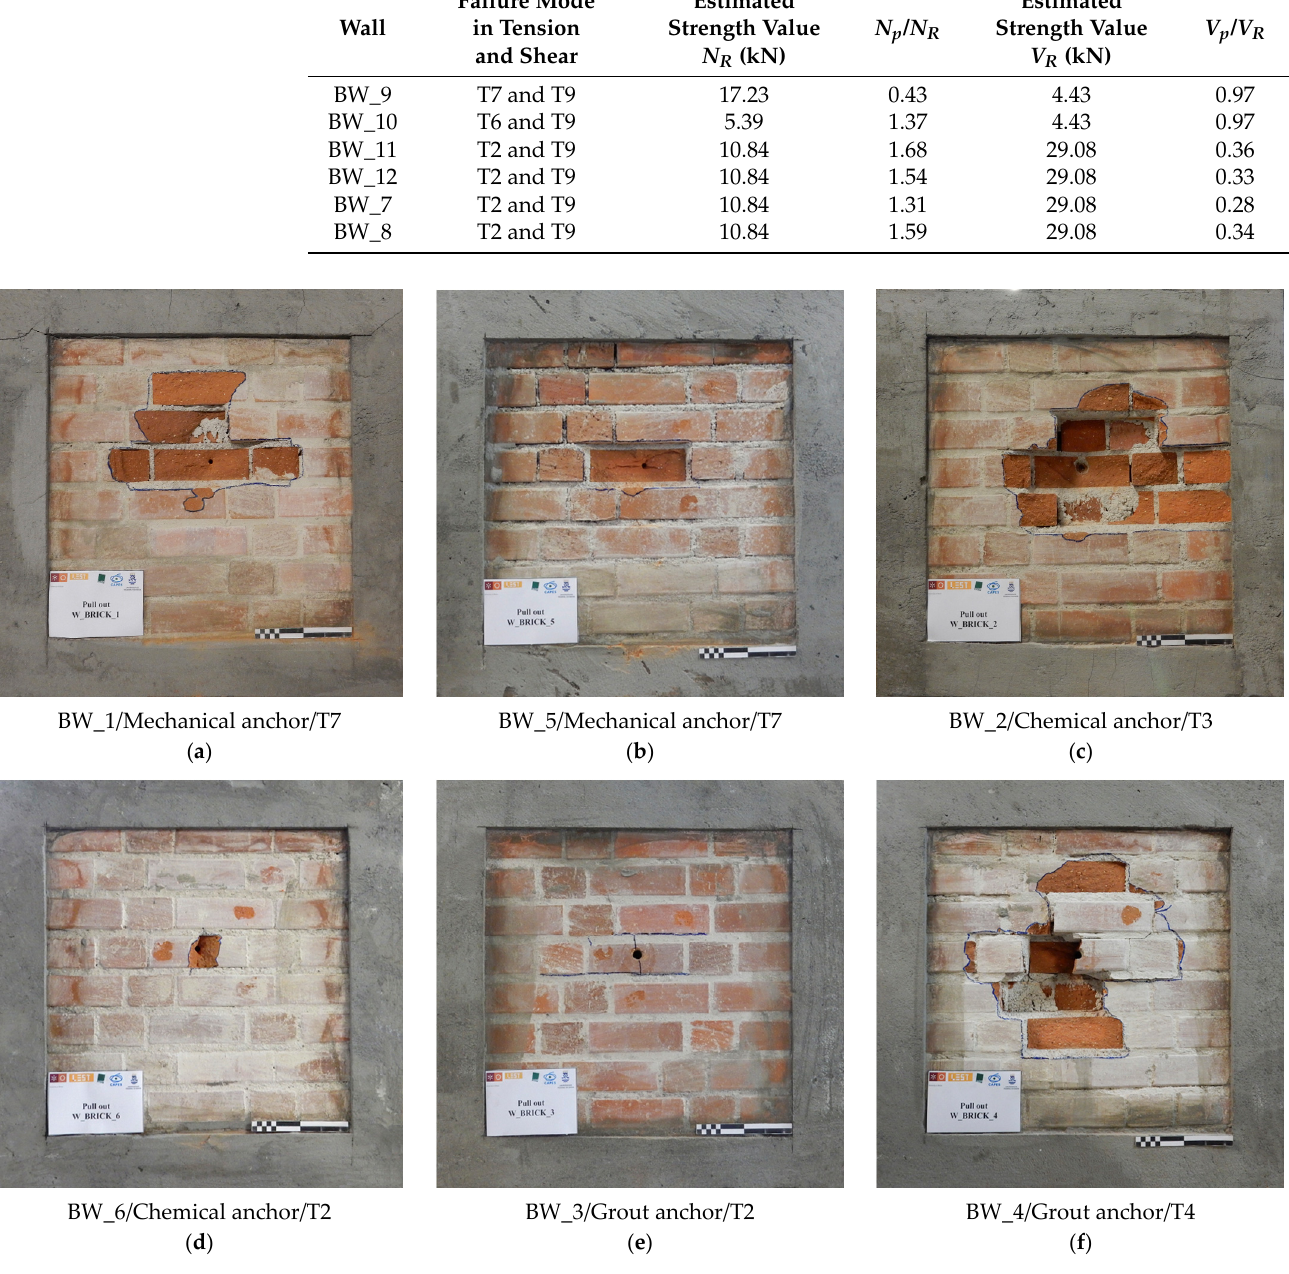
Figure 7. Failure modes obtained from the pull-out tests with horizontal actuator: ( a ) BW_1; ( b ) BW_5; ( c ) BW_2; ( d ) BW_6; ( e ) BW_3; and ( f ) BW_4.